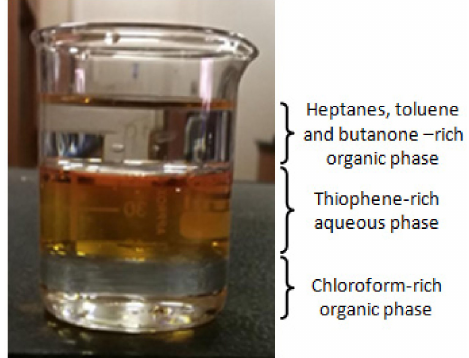
Figure 1. Behavior of the components of the mixture in the feed. Table 4. Characteristics of the various components in the feed taken from the literature at 20 ◦ C. Chloroform Toluene Heptanes Thiophene Butanone